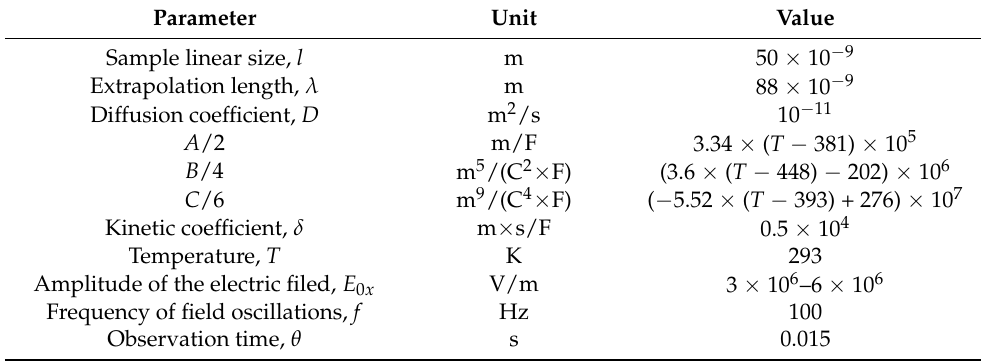
Table 1. Model parameters.